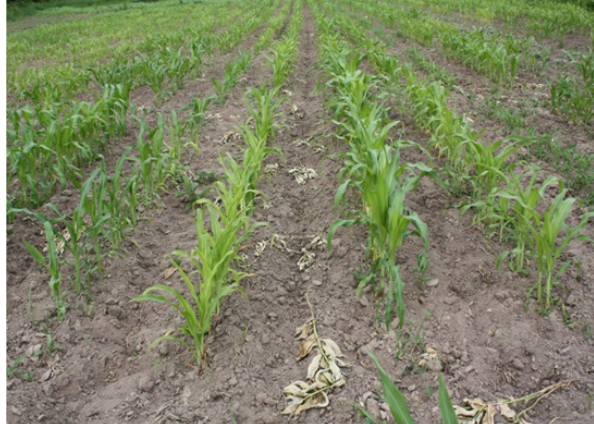
Figure 6: Differences in seedling growth for different breeding lines grown on a low organic matter, loamy sand soil in 2013 near Eagle, Wisconsin